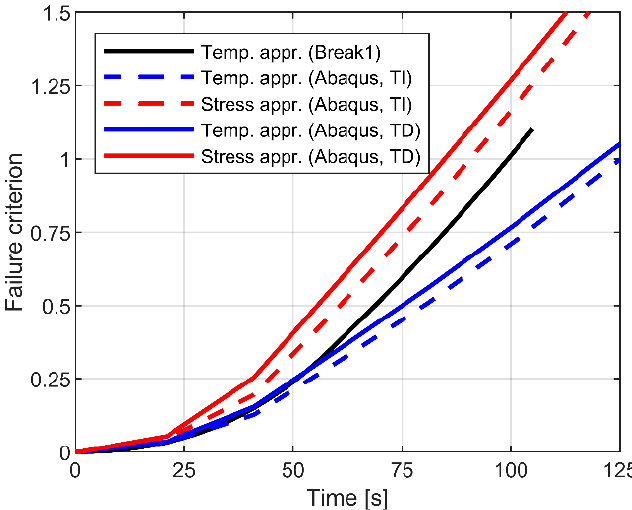
Figure 16. Comparison of failure criteria (TEMP vs. STRESS approach) for 5 mm glass pane. Notation: TI—temperature independent; TD—temperature dependent material properties.